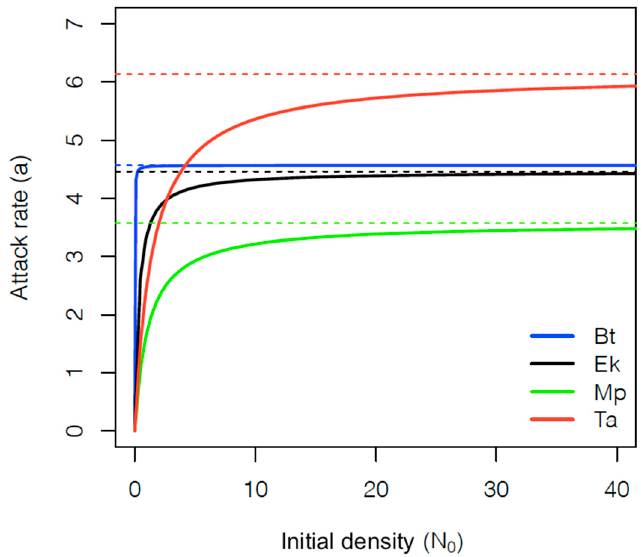
Figure 1. Attack rate as a function of initial prey density estimated by the Hassel’s extension for type III functional response (Equation (2)) of Dicyphus cerastii females preying on Bemisia tabaci 4th instar nymphs (Bt), Ephestia kuehniella eggs (Ek), Myzus persicae 1st instar nymphs (Mp) and Tuta absoluta eggs (Ta). Dotted lines represent the asymptote of the hyperbolic function ( b / c ) for each prey.